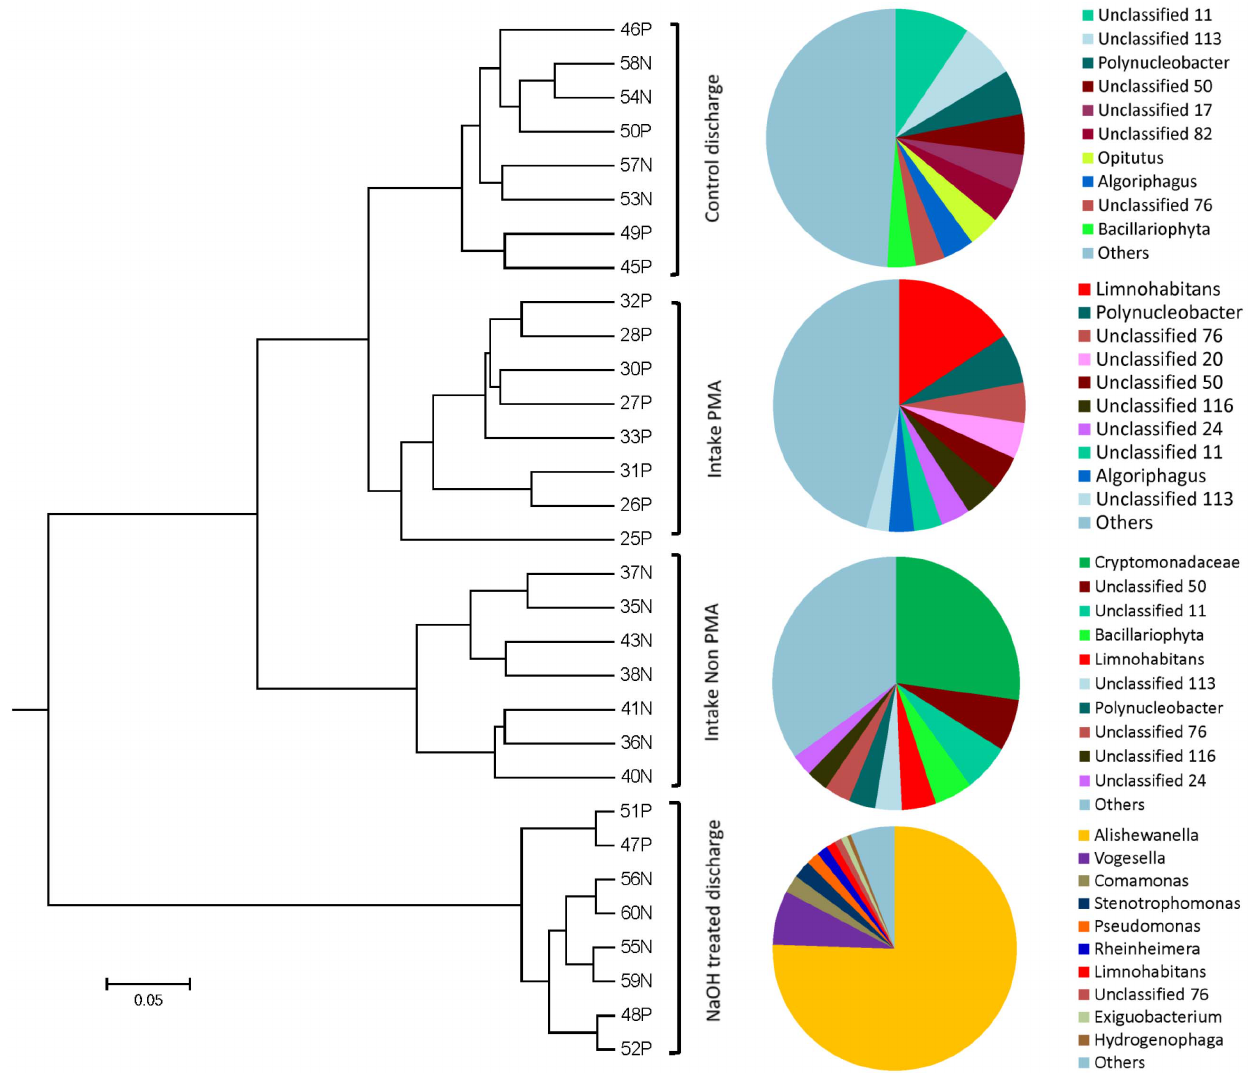
Figure 2. A UPGMA tree constructed using weighted UniFrac distance matrix among the ballast water samples. ‘‘P’’ and ‘‘N’’ in sample ID denote for PMA processed and Non-PMA processed, respectively. The Pie charts depict microbial community structure at genus level for each group. The top ten most abundant genera were shown and others were lumped in others.